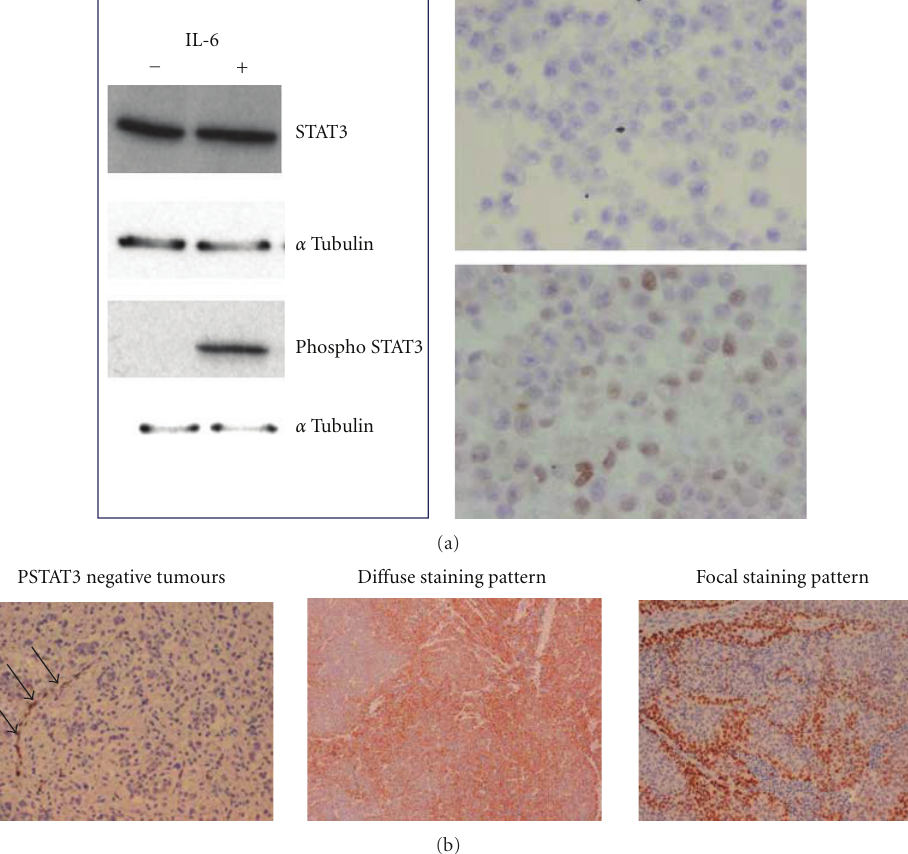
Figure 1: PSTAT3 staining identifies two distinct distribution patterns of PSTAT3 tumour cells in ESFT specimens. (a) Hela cells were cultured in the presence or absence of IL-6 prior to formation of cell pellets for generating lysate or embedding in para ffi n following formalin fixation. A phospho-STAT3-specific antibody was used to probe lysates by Western blot or to stain cells by immunohistochemistry, magni- fication × 200. (b) Representative staining patterns of primary ESFT samples. In the left panel, tumor cells are P-STAT3 negative whereas endothelial cells stained positive for PSTAT3 (acting as an internal positive control, black arrows), magnification ×